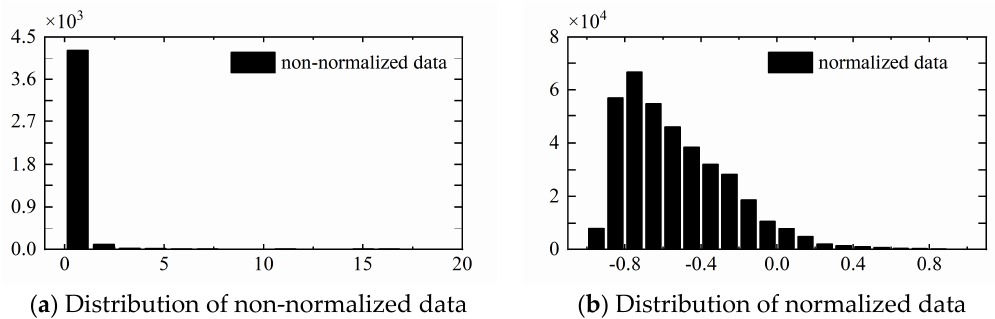
Figure 4. Comparison of histograms before and after the data normalization.